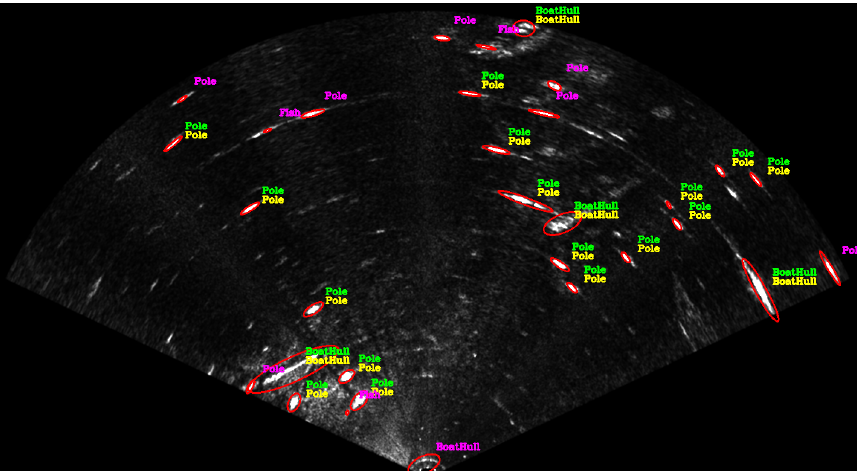
the classification assigned by the classifier. The green labels indicate correct classification, red labels indicate incorrect classification, and magenta labels indicate segments without annotation to